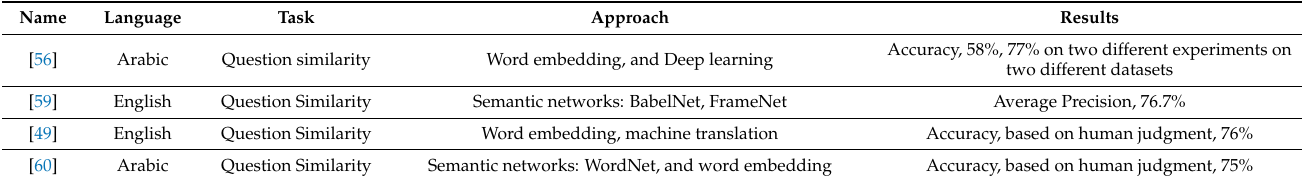
Table 8. Comparison with the state-of-the-art systems for question